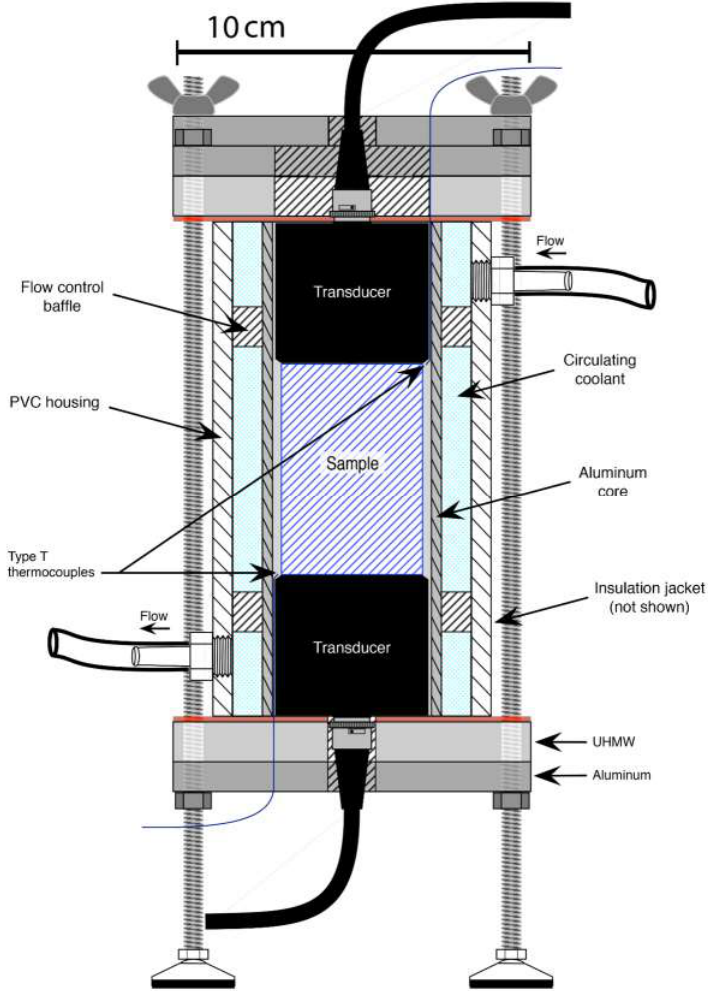
Figure 3. Schematic of the ultrasonic tester within its cryostat. Transducers are held on either side of the cylindrical sample and connect to a touchscreen controller. Circulating fluid controls the temperature, which is monitored by thermocouples.